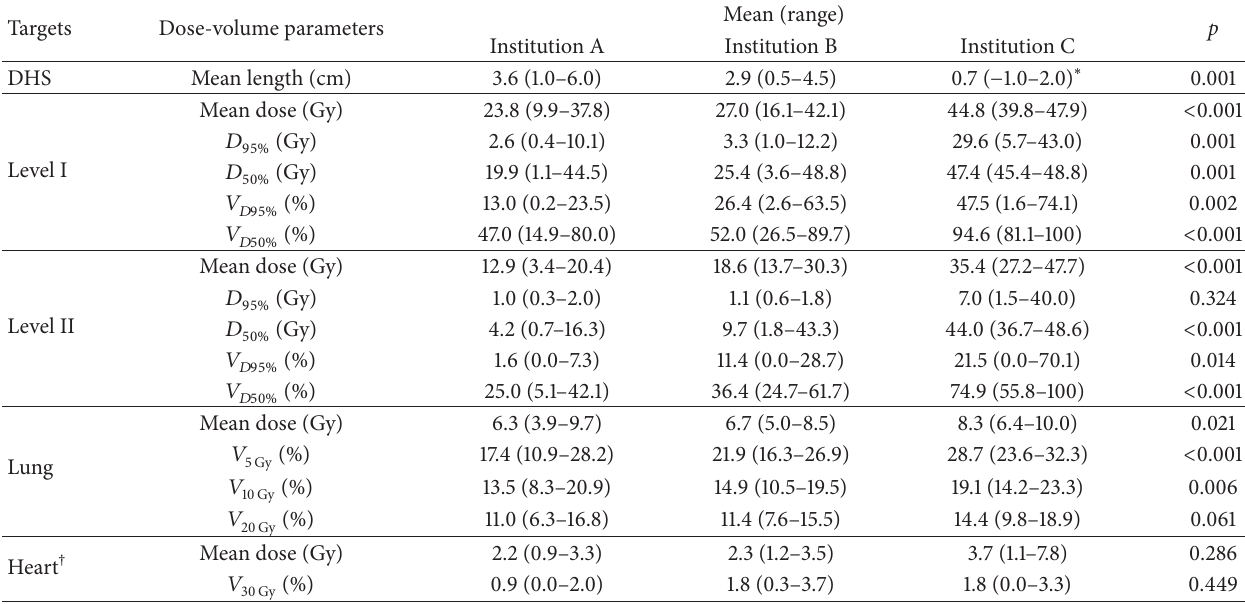
Table 2: Dose-volume parameters comparison between the three institutions.